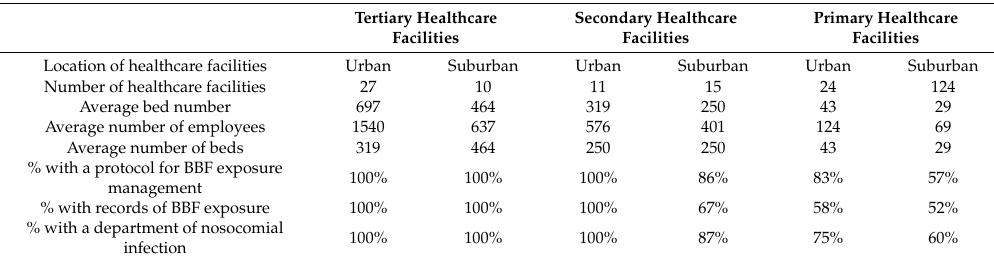
Table 1. Characteristics of the surveyed healthcare facilities in